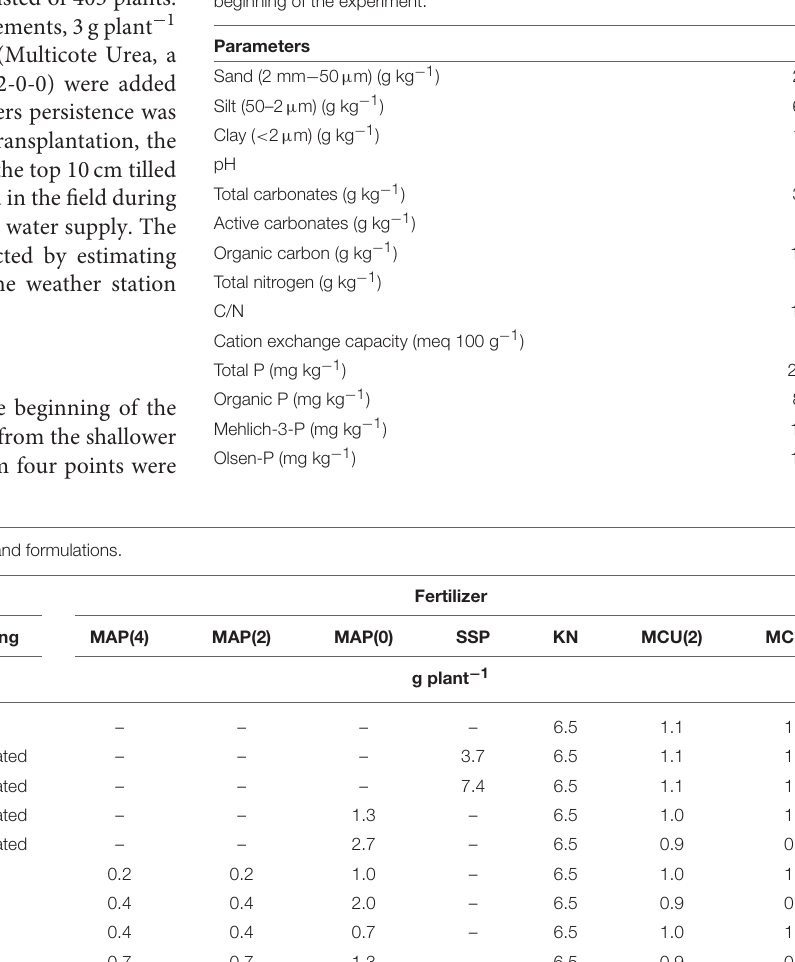
TABLE 2 | Main physical and chemical characteristics of the soil (0–20cm) at the beginning of the experiment.